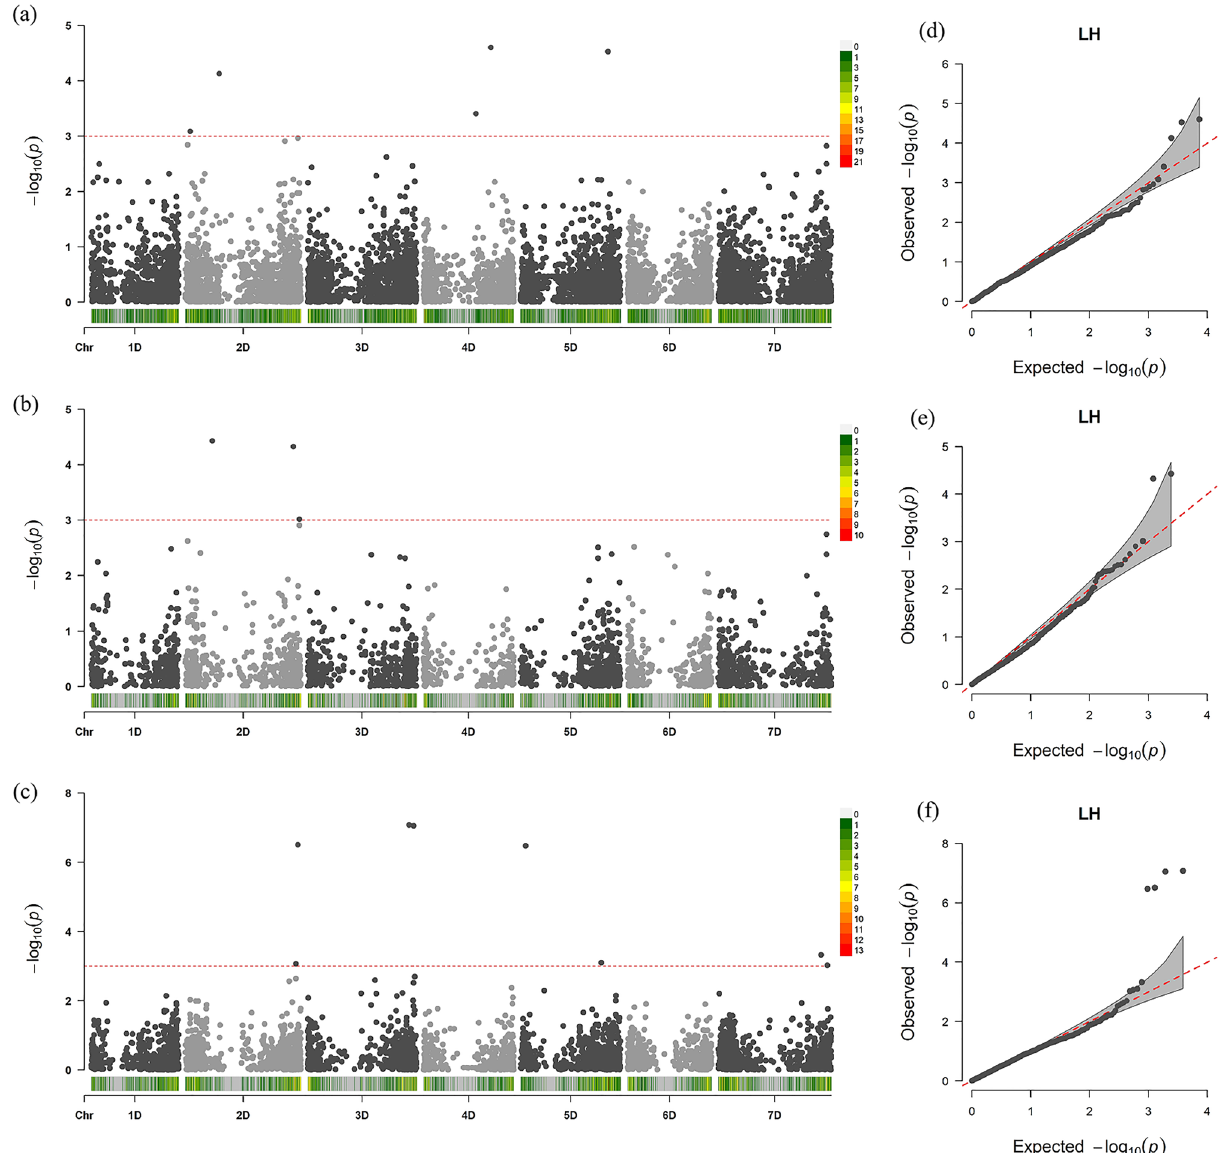
Figure 3. Manhattan plots illustrating Aegilops tauschii single nucleotide polymorphism (SNP)-LHD associations detected by a mixed linear model using BLUP values in ( a ) all accessions, ( b ) TauL1, and ( c ) TauL2. Genomic coordinates are displayed along the X-axis, with the negative logarithm of the association p-value for each SNP displayed on the Y-axis. Redline indicates the significance threshold. Q-Q plots showing deviation of GWAS results from the null hypothesis for leaf hairs in ( d ) all accessions, ( e ) TauL1, and ( f )